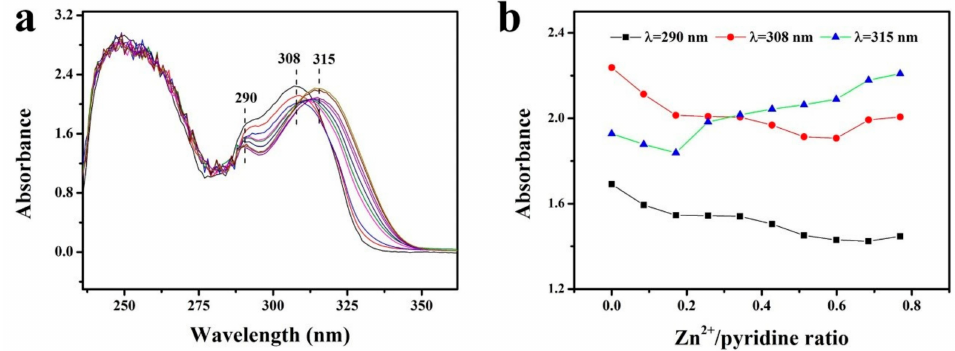
Figure 3. ( a ) UV-vis spectra variation with titration of a solution of zinc salt into diluted PUU-Py solution in THF; ( b ) variation of absorbance at specific wavelength ( λ = 209, 308 and 315 nm) plotted to the Zn 2 + / pyridine molar